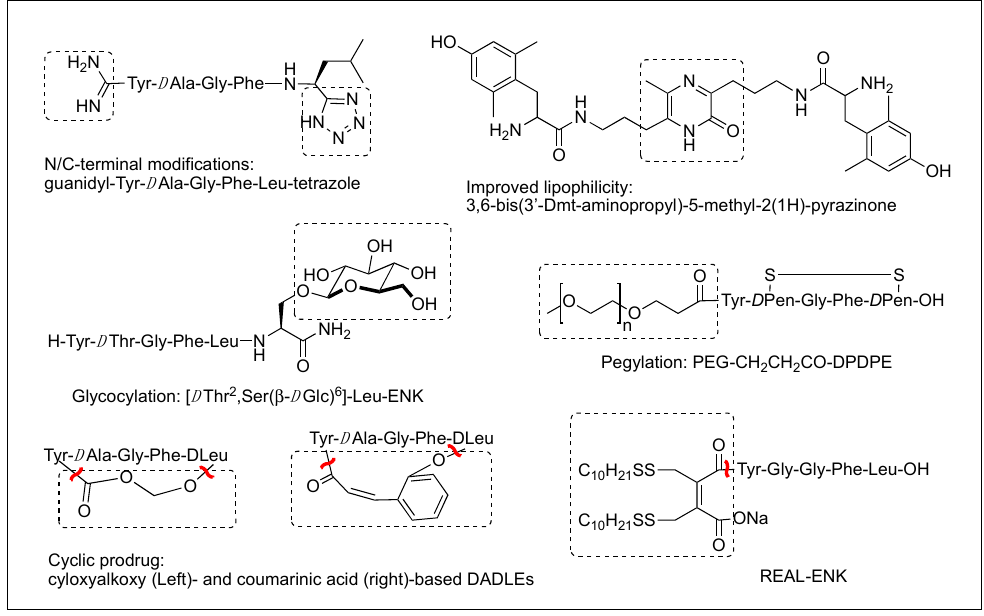
Figure 2. Various modifications to optimize metabolic stability, BBB permeability, and oral bioavailability.